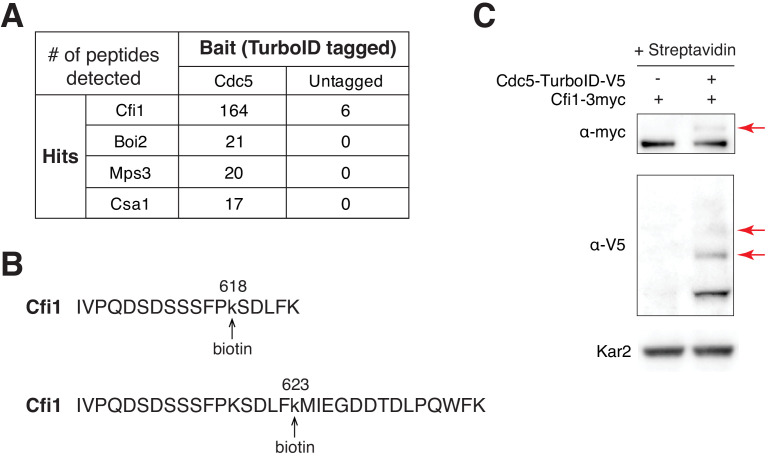
Cdc5 interacts with Cfi1/Net1 in vivo.(A) Results of TurboID proximity-based biotinylation for Cdc5 (A41385 and A2588). (B) Biotinylated peptides of Cfi1/Net1 detected in cells with Cdc5-TurboID. (C) Streptavidin gel-shift assay to probe the interaction between Cdc5-TurboID and Cfi1/Net1 (A1638 and A41418). Cells were grown at room temperature in YPED. Lysates were treated with streptavidin and immunoblotted as indicated. Red arrows highlight biotinylated proteins.